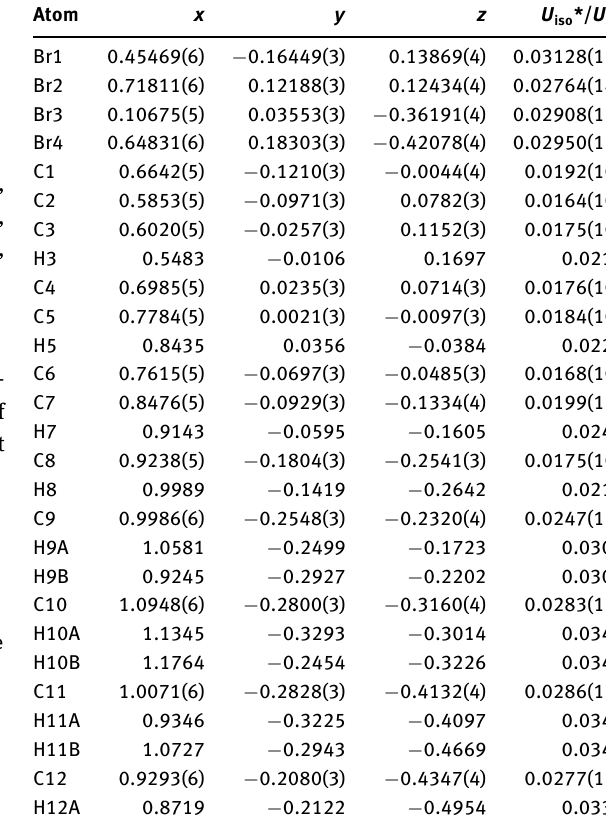
Table 2: Fractional atomic coordinates and isotropic or